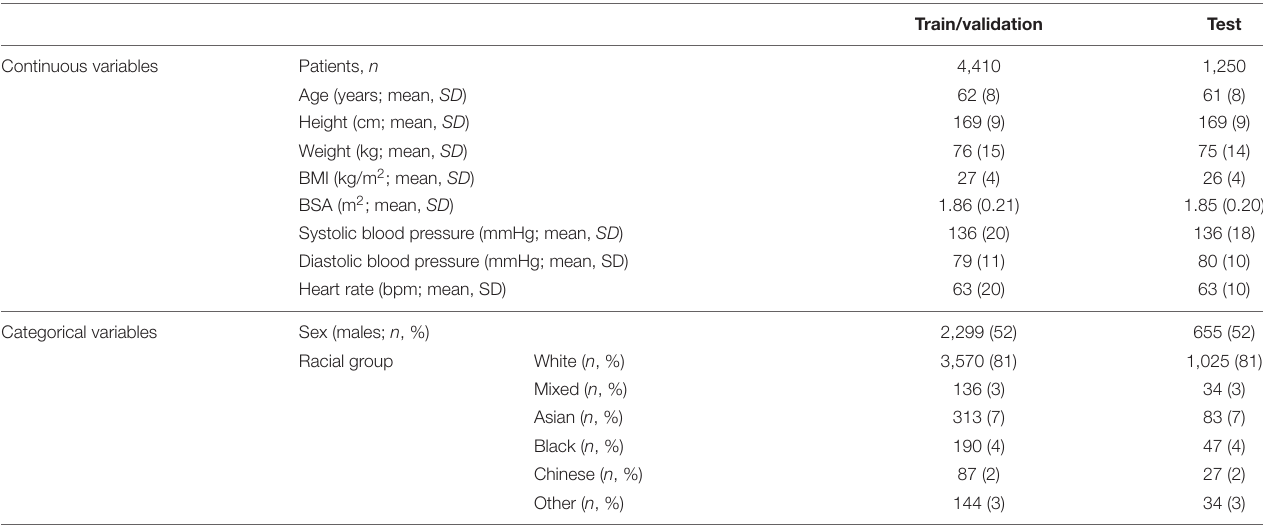
TABLE 1 | Population characteristics for the train/validation and test